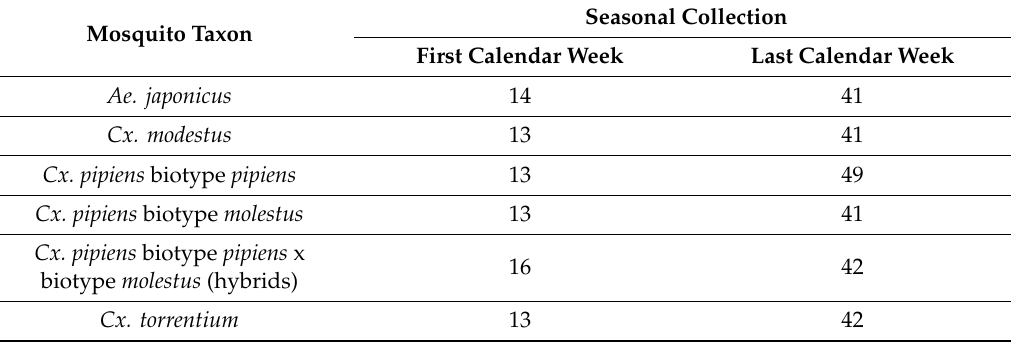
Table 4. Seasonal activity of major WNV vector taxa in Germany, based on trap collections of females from April to October 2011 to 2018 (24 h per